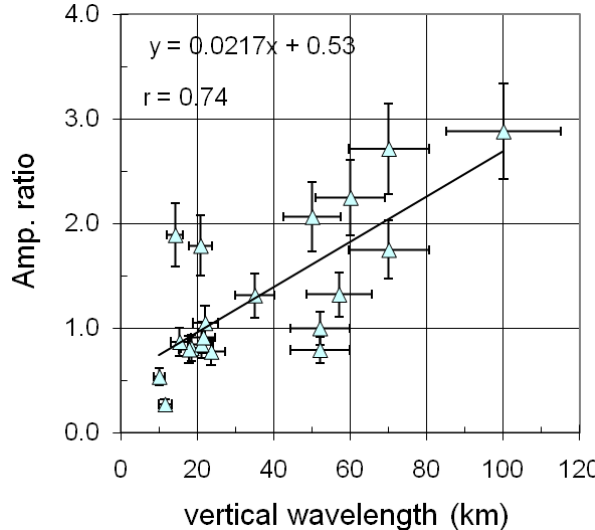
Fig. 4. Ratio of amplitude of oscillation between the O 2 and OH emission intensities against the phase difference between the two emissions. The straight line is a linear regression curve and “ r ” represents the correlation coefficient.